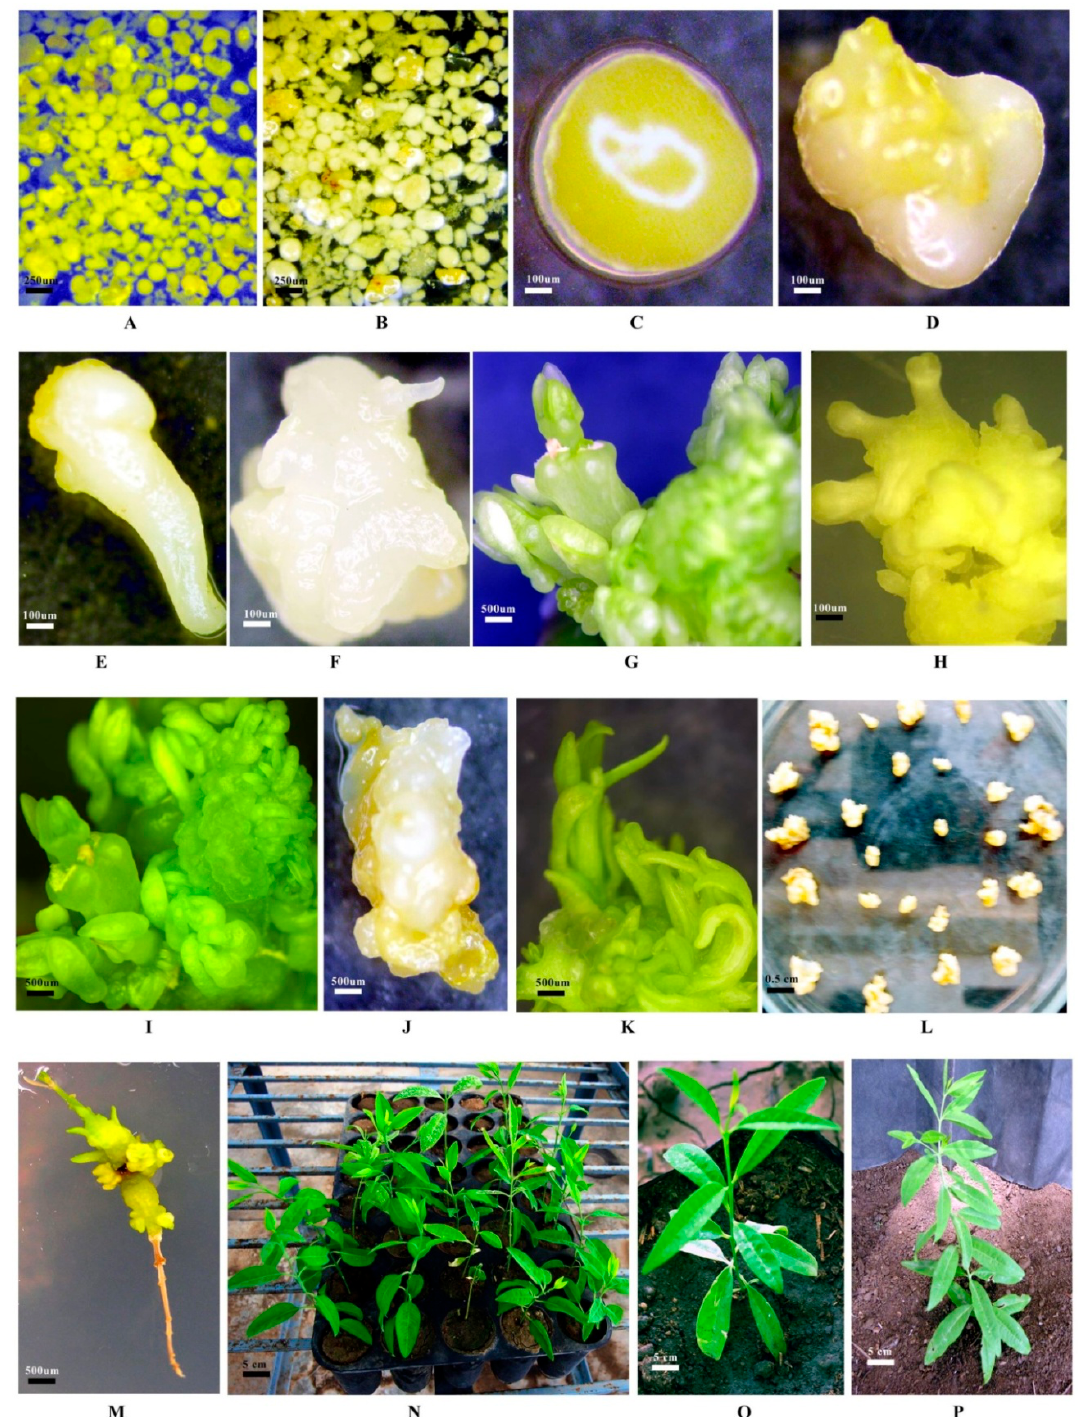
Figure 1. Plant regeneration from cell suspension culture in Santalum album L.: ( A ) initiation of cell clumps and embryoid formation raised from embryogenic calli of mature embryonic axis; ( B ) initiation of cell clumps and embryoid formation derived from embryogenic calli of mature cotyledons; ( C ) globular stage embryoid; ( D ) heart stage embryoid; ( E ) torpedo stage embryoid; ( F ) typical bipolar embryoid; ( G ) germination of bipolar embryoid; ( H ) multiple embryoids; ( I ) germi- nationof multiple embryoids; ( J ) typical multipolar embryoid; ( K ) germination of multipolar embryoid; ( L ) embryoid/cell clumps transferred on regeneration medium; ( M ) rooting of regenerants; ( N ) regenerants transferred in the greenhouse for hardening; ( O ) regenerants subjected to the net house for hardening; ( P ) regenerants shifted in the field for hardening.